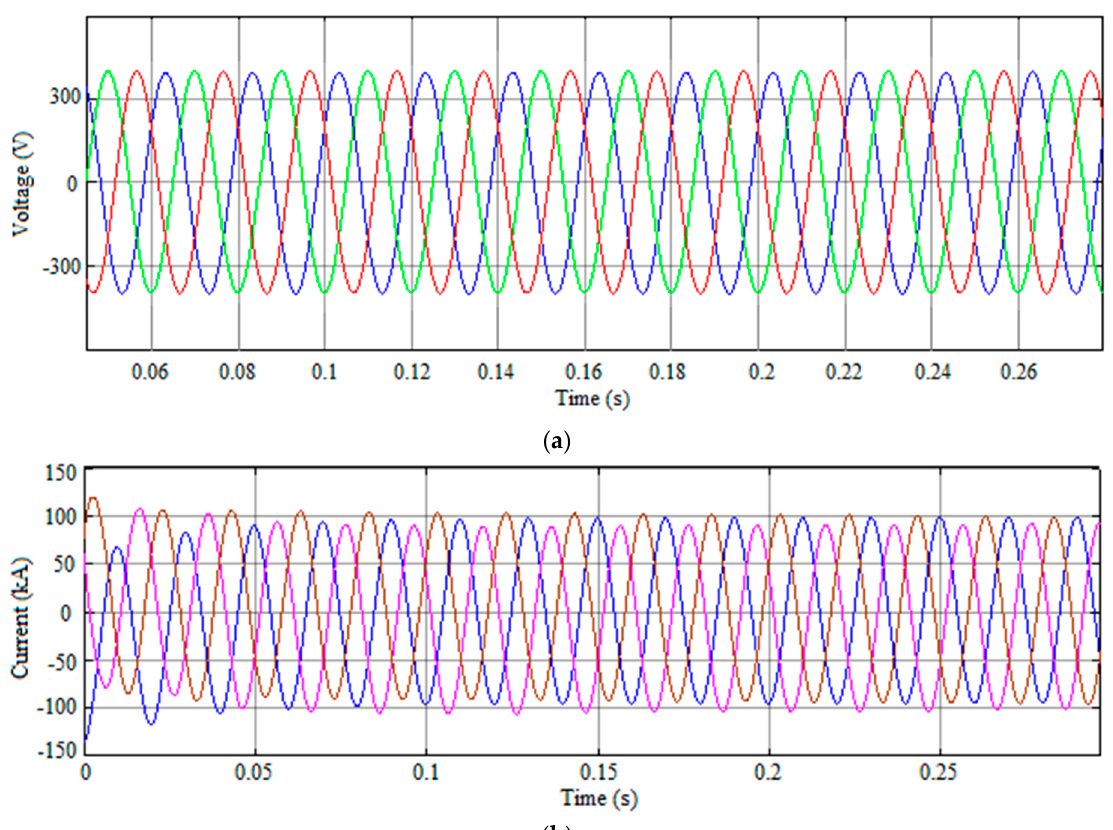
Figure 8. Voltage and current (input to MC).